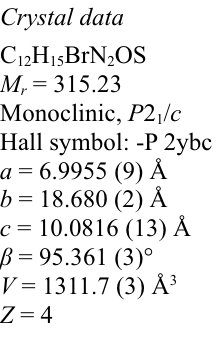
Part of the structure showing the formation of endless chains involving N—H···O hydrogen bonds. 4-Bromo- N -(diethylcarbamothioyl)benzamide Crystal